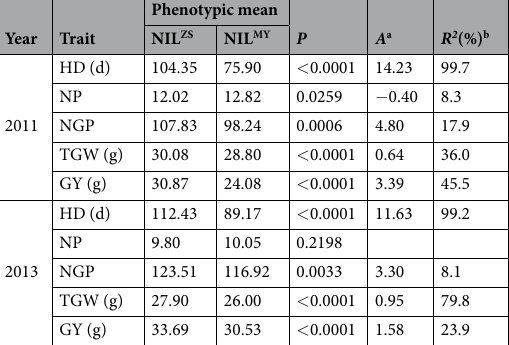
Table 3. Validation of the effect of RFT1 on HD and yield traits. NIL ZS and NIL MY are near isogenic lines carrying homozygous RFT1 alleles from ZS97 and MY46, respectively. Twenty NIL ZS lines and 20 NIL MY lines of the R1 population were grown in Hangzhou, using a randomized complete block design with two replications. HD, heading date. NP, number of panicles per plant. NGP, number of grains per panicle. TGW, 1000-grain weight. GY, grain yield per plant. a A , additive effect of replacing a MY46 allele with a ZS97 allele. b R 2 , proportion of phenotypic variance explained by the QTL